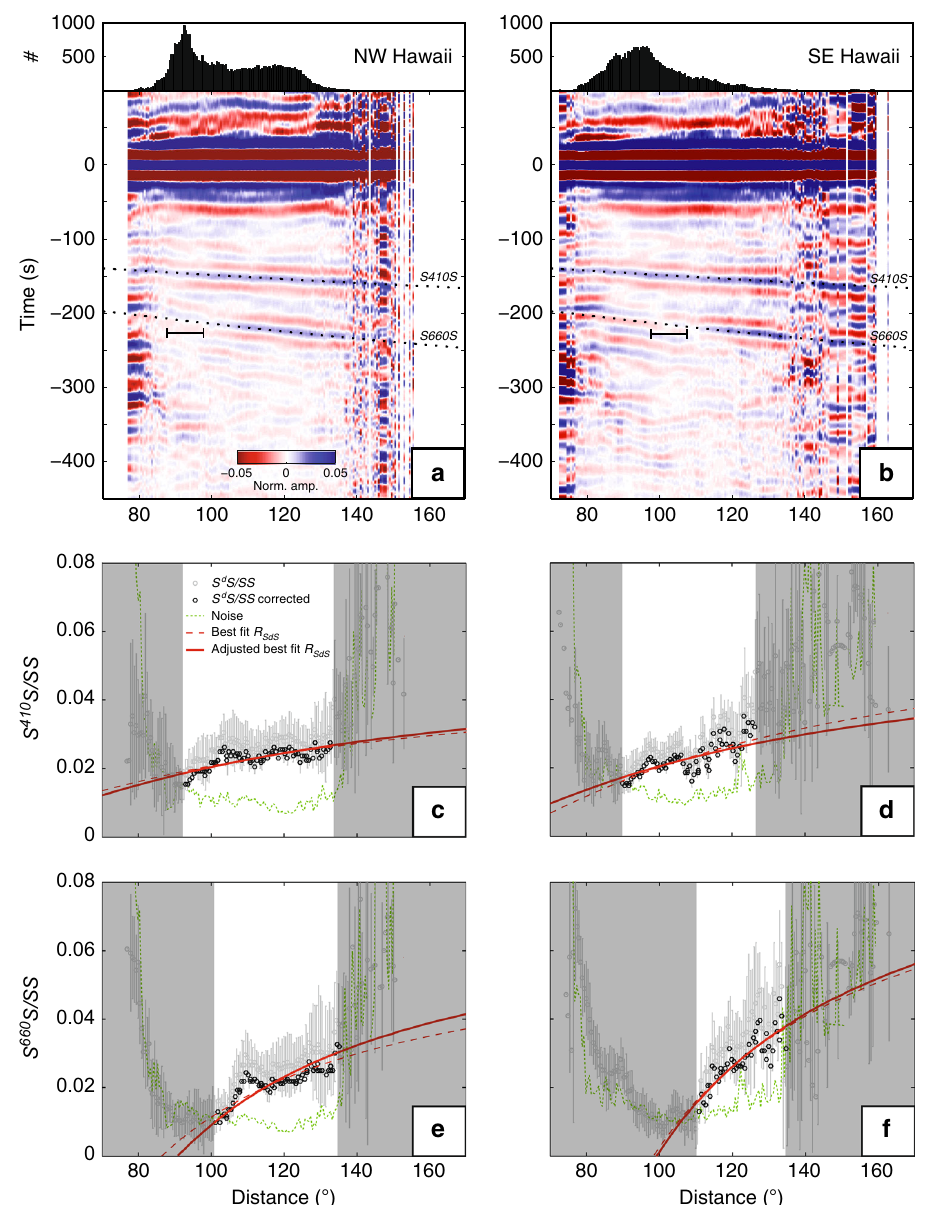
Fig. 4 Waveform stacks and associated amplitude – distance curves for SS data that sample the mantle transition zone NW and SE of Hawaii. a , b show the fi ltered time – distance plots for the two regions, and c – f the amplitude – distance plots for the two regions and two discontinuity depths. Horizontal bars in a , b mark polarity transition distances based on visual inspection. In c – f , the solid and dashed red lines represent the best fi ts of the re fl ection coef fi cients with and without thermodynamic adjustment, respectively (the former uses thermodynamically derived Δ ρ / Δ β